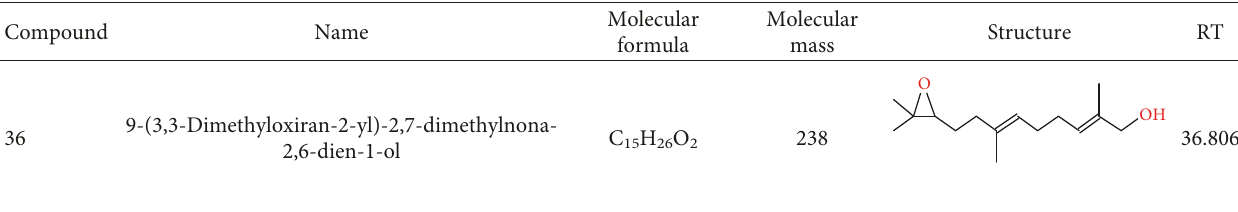
Table 9: Molecular formula, molecular mass, structure, and RTof compounds 36–40 of whole plant n -hexane fraction of Achillea wilhelmsii